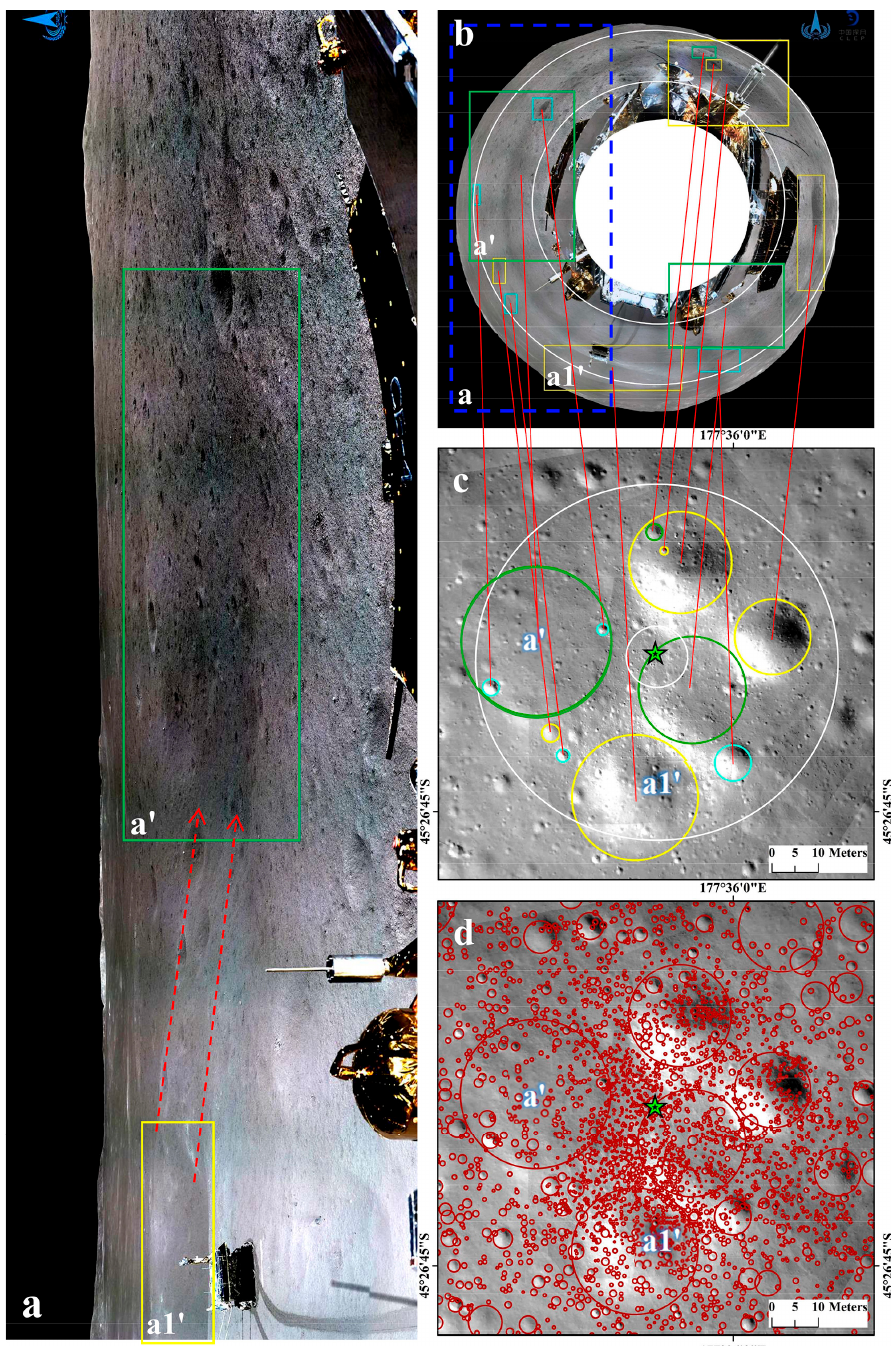
Figure 9. The corresponding impact craters in the TCAM and LCAM mosaic images. ( a ) Part of the enhanced ground TCAM image (cylindrical projection), corresponding to the area shown in the blue dashed box in ( b ). The red dashed arrow shows the direction of ejection from crater a1’ to crater a’. ( b ) Ground TCAM image (azimuthal projection). The red solid lines show 12 corresponding craters with different degradation levels. Aquamarine, yellow, and green outlined areas in ( b , c ) are C2, C3, and C4 craters. The areas within the white circles in ( b , c ) are the study areas where TCAM images were used to verify the degradation level of impact craters. ( c ) The LCAM mosaic image. ( d ) Distribution of LCAM impact craters corresponding to the TCAM image. The green pentagram is the Chang’e-4 landing site.